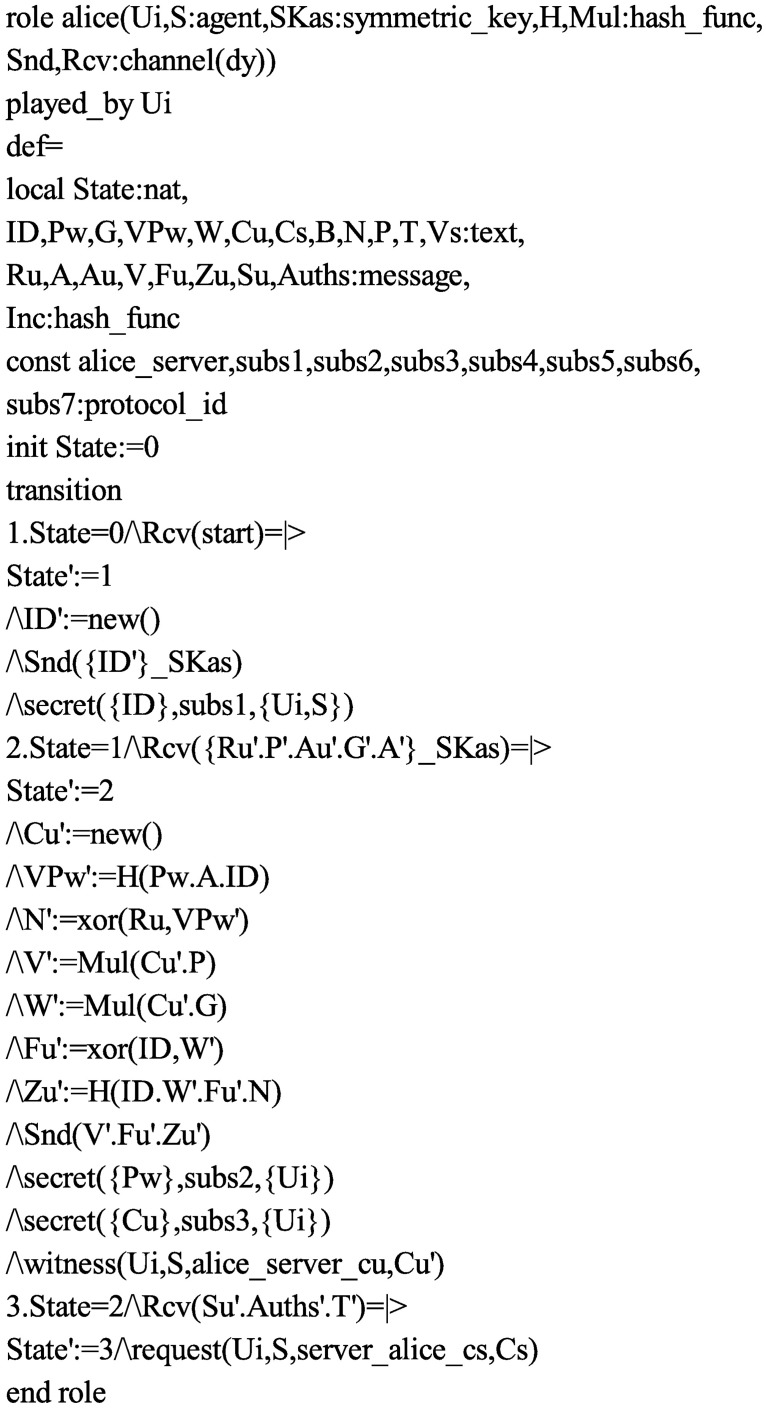
Role specification of Ui in HLPSL.